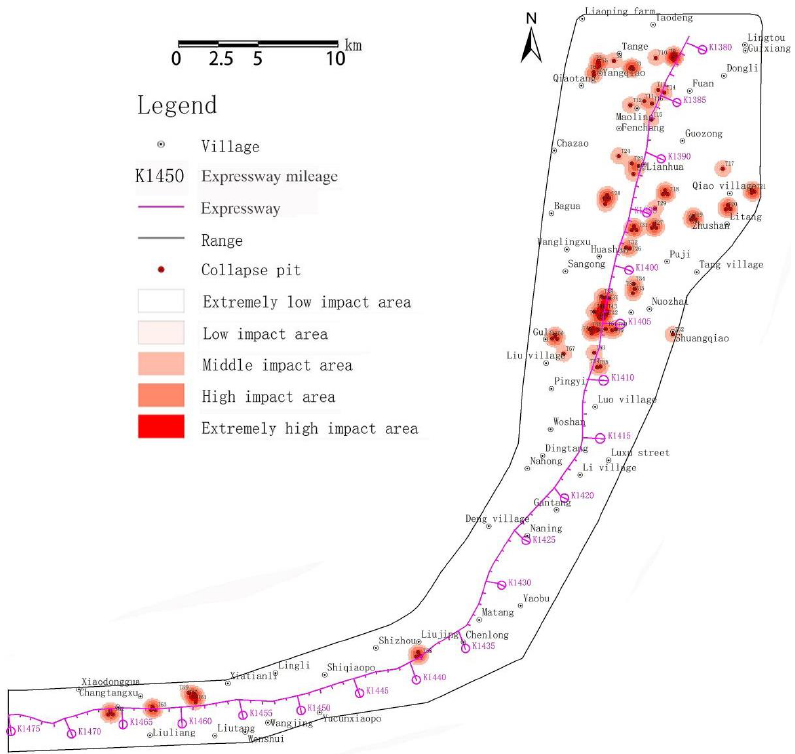
Water 2022 , 14 , x FOR PEER REVIEW Figure 12. Zoning map of influence degree of existing karst collapse in the research area.